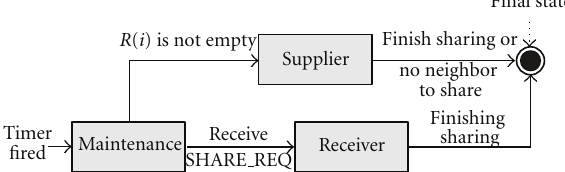
Figure 8: Energy sharing protocol.